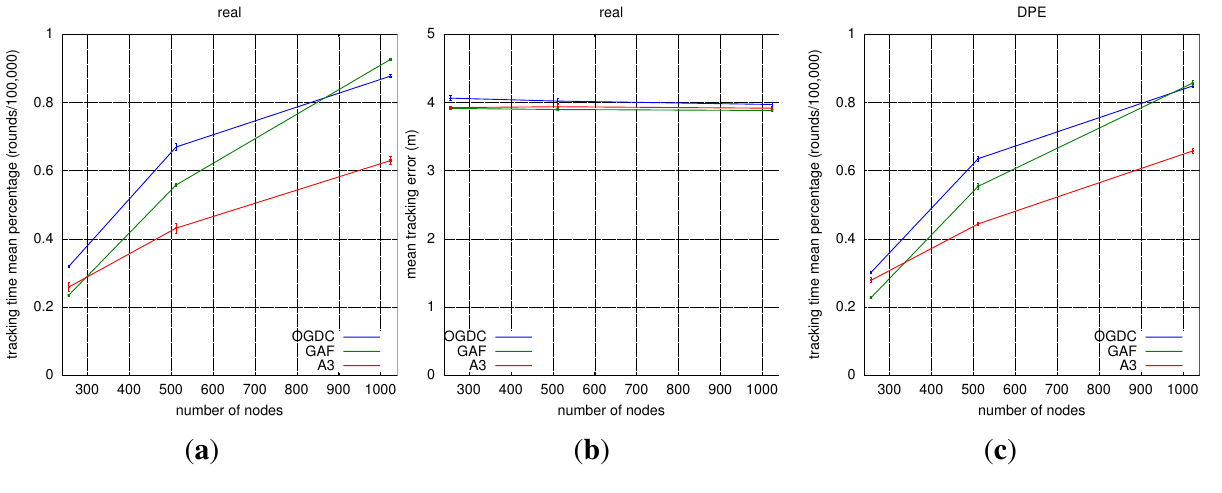
( b ) Mean Tracking Error (Real); ( c ) Mean Tracking Time (DPE); ( d ) Mean Tracking Error (DPE); ( e ) Mean Tracking Time (RPE); ( f ) Mean Tracking Error